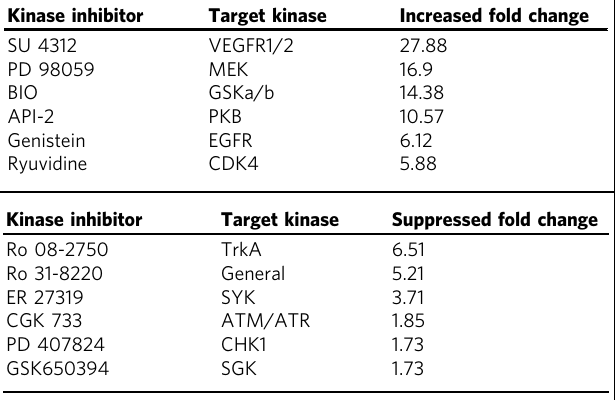
Table 1 Results of kinase inhibitor screen using the LATS-BS Kinase inhibitor Target kinase Increased fold change SU